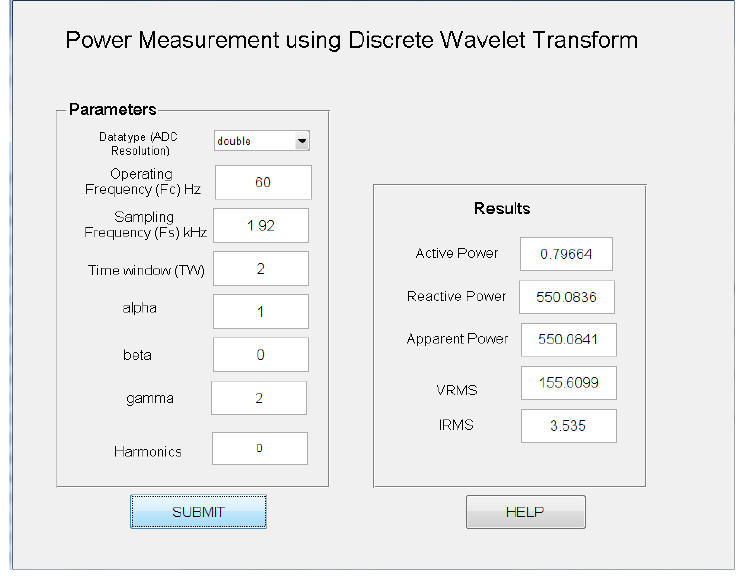
Figure 10. GUI for power measurement